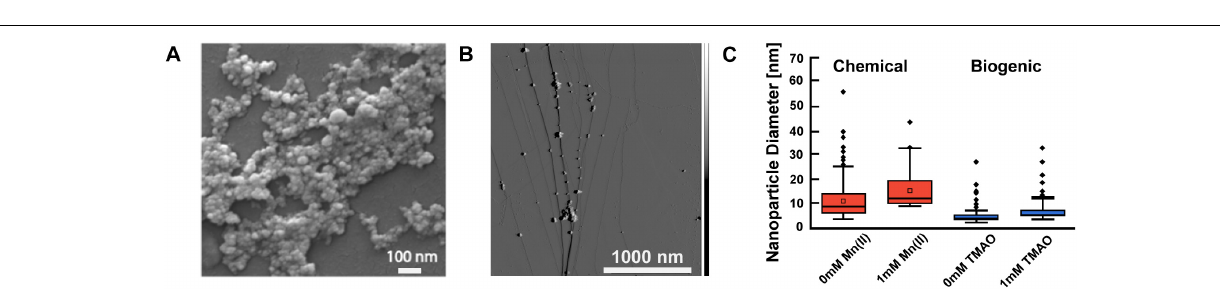
FIGURE 4 | Electron microscopy and atomic force microscopy characterization of biogenic Mn doped zinc sulfide nanomaterials. (A) SEM image of Mn doped zinc sulfide nanomaterials (chemical synthesis 1% Mn). (B) AFM image of biogenic Mn doped zinc sulfide nanomaterials. (C) Sizes of nanomaterials synthesized via chemical method and biogenic method using AFM. A minumum of 150 nanoparticles were analyzed ( n > 150); particle clusters were omitted. The box indicates the interquartile range, which captures all the data between the first and third quartile. The horizontal line within the box represents the mean or expected value. The bars extending above and below indicate the min and max of the data, excluding outliers. The dots outside the min and max lines represent outliers, which are values 1.5 inner quartile range distance from the inner quartile. The box plot represents data from one replicate of each sample. Comparison of particle sizes using an unpaired Student’s t -test revealed that all pairs of measurements were significantly different ( p < 0.01) except for biogenic particles at 0 and 1 mM TMAO which had a p >